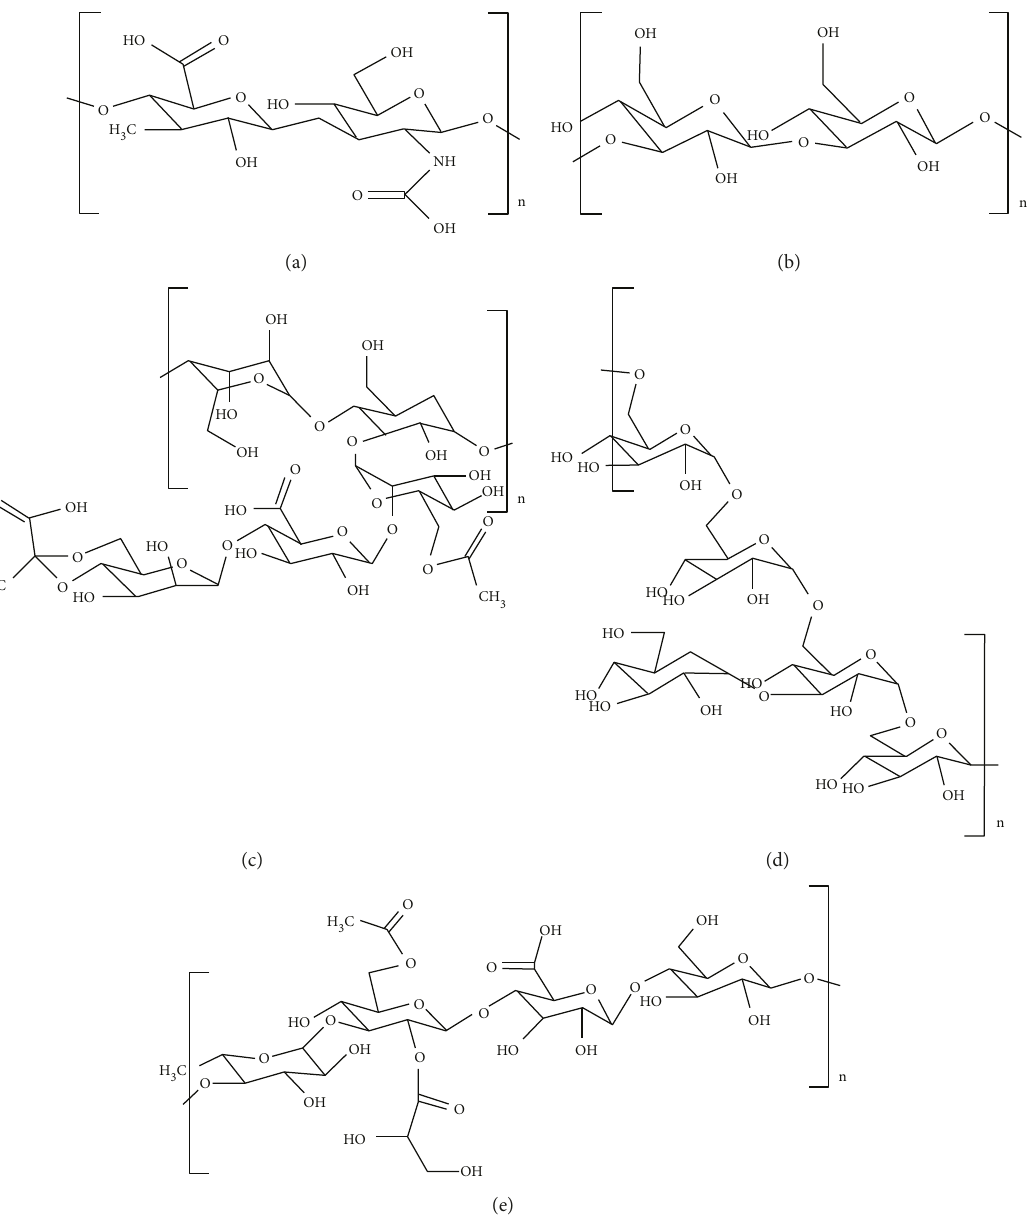
Figure 1: Structure of some microbial exopolysaccharides. The chemical structure of diverse microbial EPSs can di ff er in functional groups or sugars branched in the main chain structure. (a) Hyaluronic acid, (b) curdlan, (c) xanthan, (d) dextran, and (e) gellan. The “ n ” indicates the polymerization degree of the polysaccharides, and it can vary signi fi cantly from bacteria strain and culture